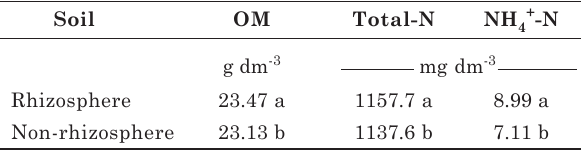
Table 2. Organic matter (OM), total-N and ammonium (NH 4 + -N) in the rhizospheric and non-rhizospheric soils of Brachiaria sp. (mean of five evaluation times and four brachiaria species)